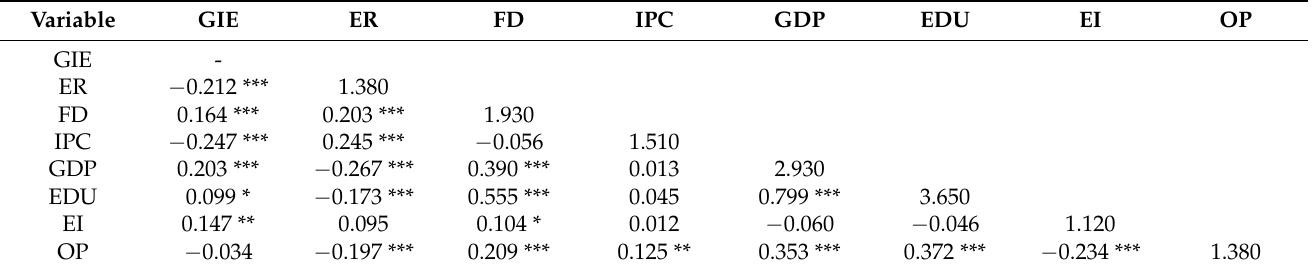
Table 3. Correlation coefficients and multiple covariance